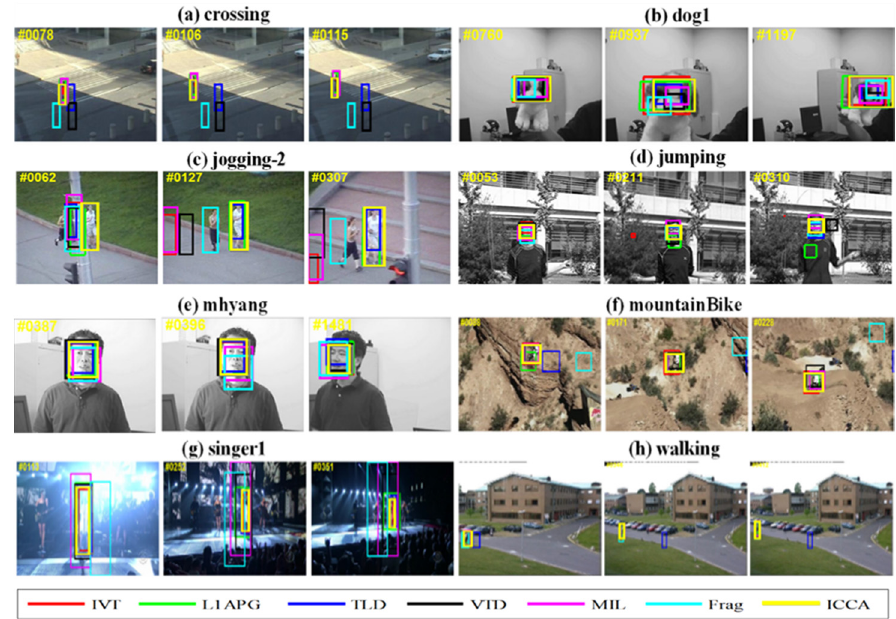
Figure 2. Tracking results of several trackers on eight videos. The bounding boxes of several trackers on three representative frames of ( a ) crossing, ( b ) dog1, ( c ) jogging-2, ( d ) jumping, ( e ) mhyang, ( f ) mountainBike, ( g ) singer1, and ( h ) walking,